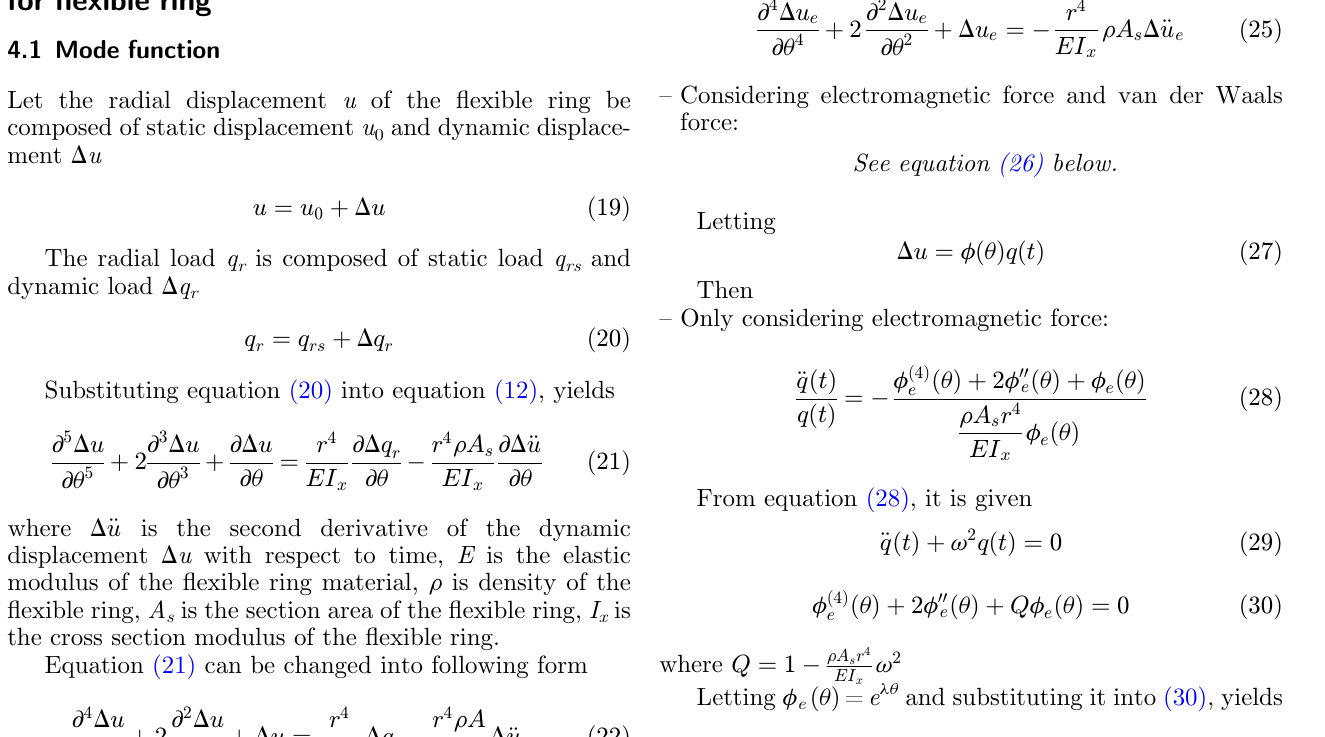
ffiffiffiffiffiffiffiffiffiffiffiffiffiffiffiffiffiffiffiffiffiffiffiffiffi ffiffiffiffiffiffiffiffiffiffiffiffiffi p p 1 þ 1 (cid:1) Q